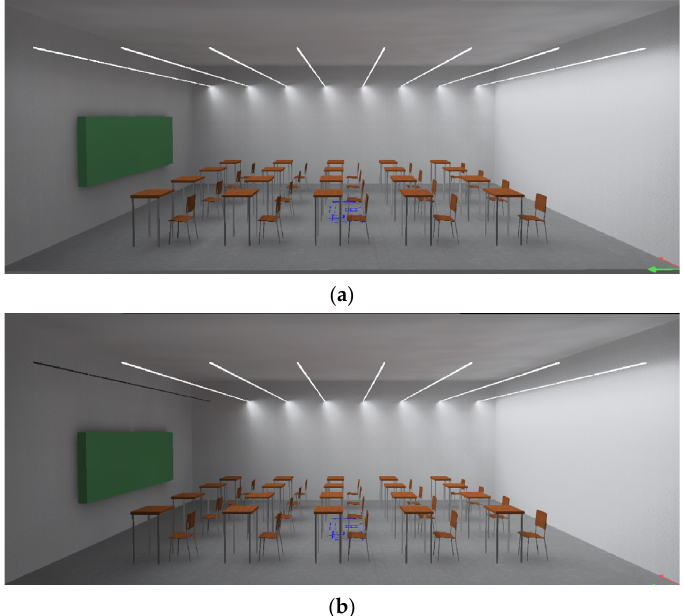
Figure 15. The 3D simulation graph of lighting environment. ( a ) all luminaires turn on. ( b ) 1st row luminaires turn off.